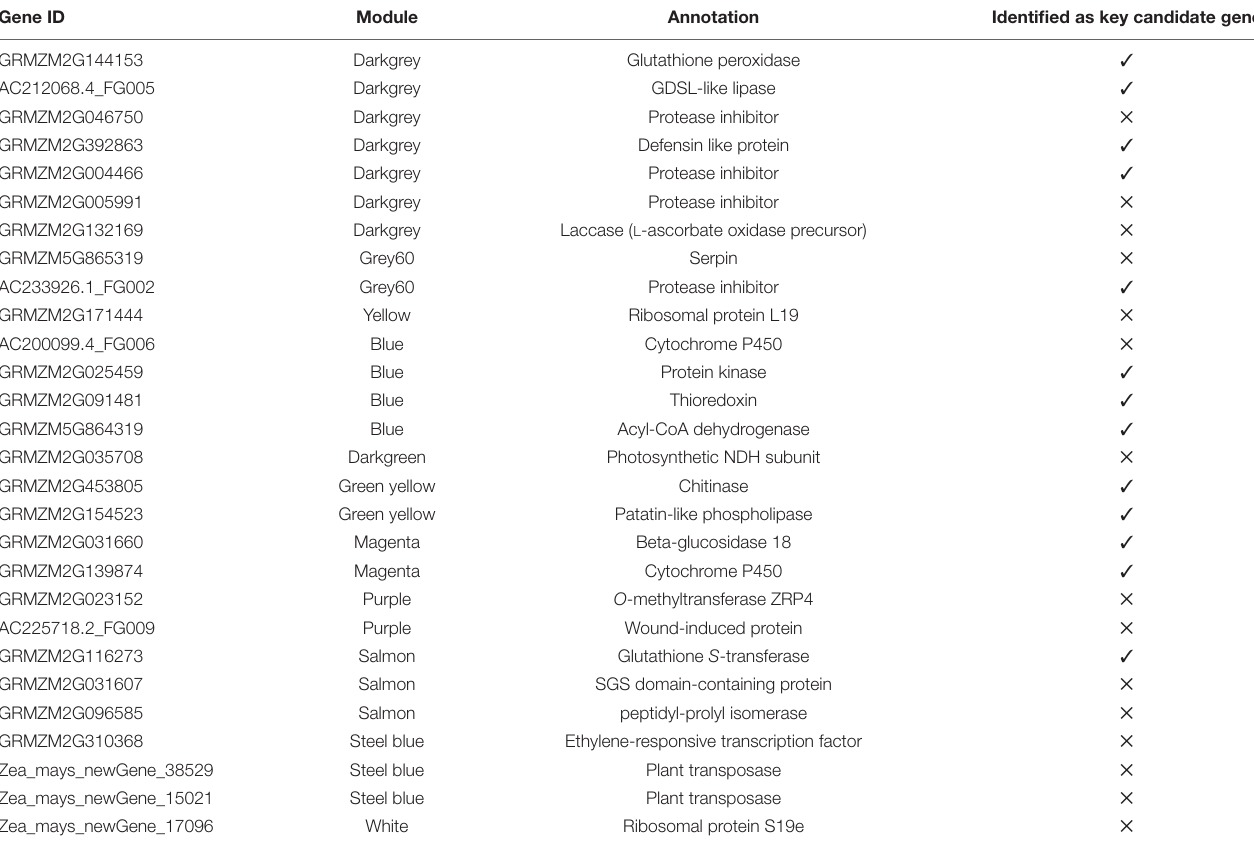
TABLE 5 | Selected hub genes from all coexpressed modules with functional annotation. Gene ID Module Annotation Identified as key candidate gene